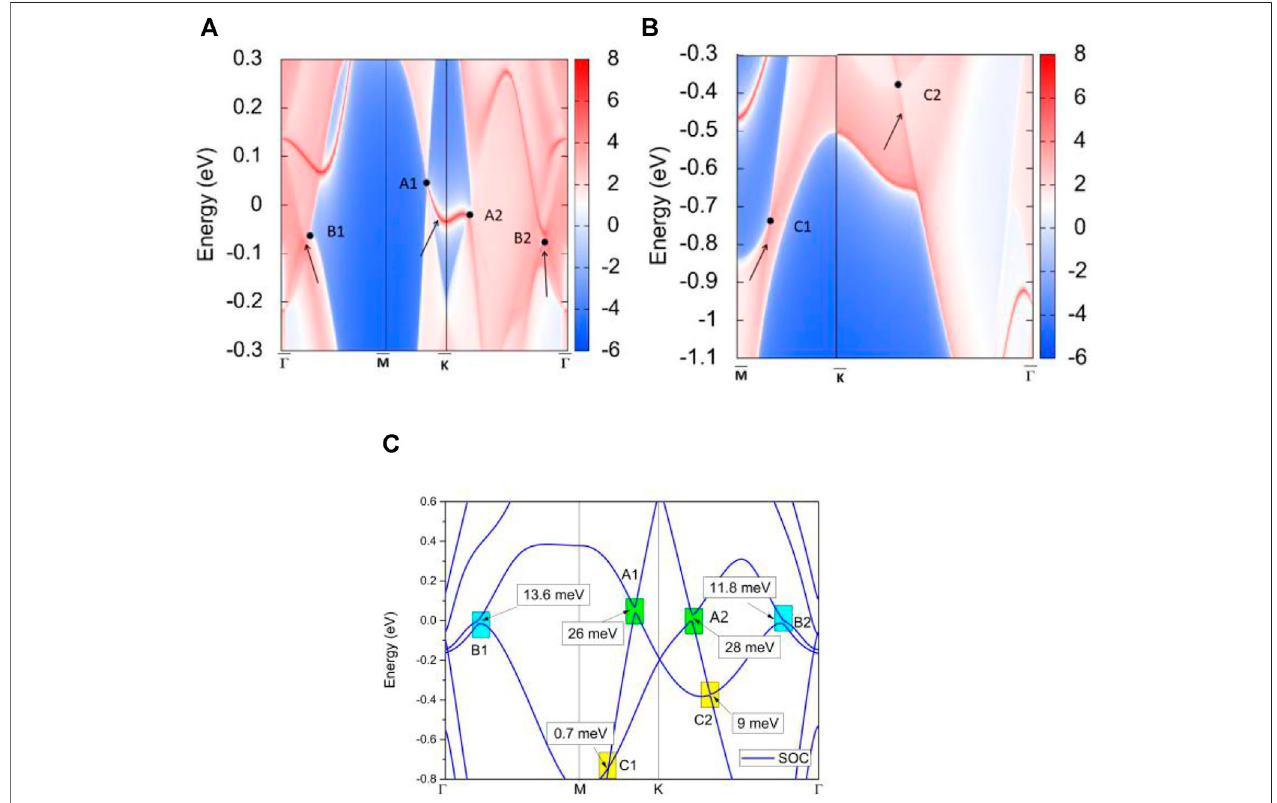
FIGURE 8 | (A,B) The projected spectrum on the (001) surface of TiTe. The BCPs — A1, A2, B1, B2, C1, and C2 — and the drum-head-like surface states are highlighted by the circles and arrows, respectively. (C) The band structure of TiTe under spin-orbit coupling.